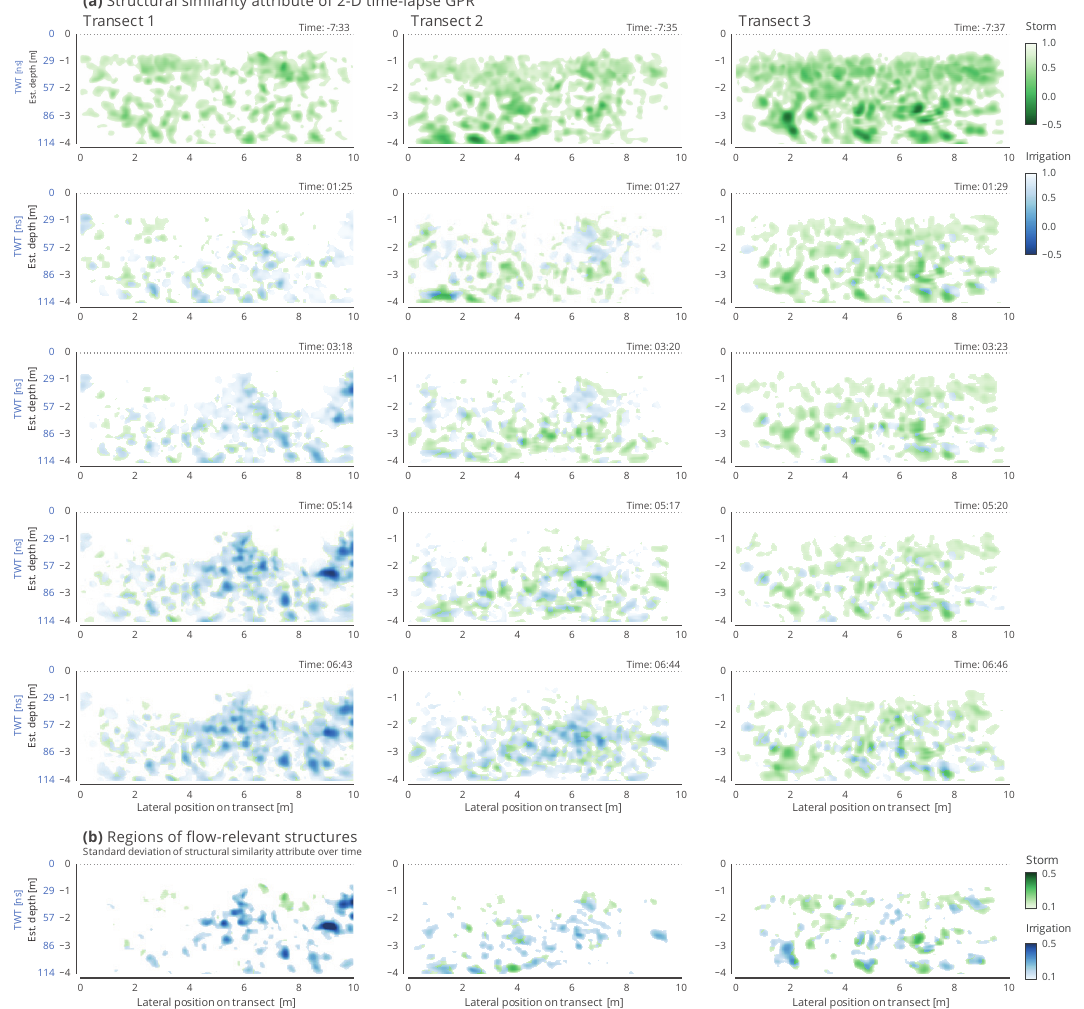
Figure 12. Structural similarity attribute in time-lapse 2-D GPR transects. Blue: irrigation event water; green: storm event water. Columns: time series in one transect; rows: different transects at the same time. (b) Identified regions of rapid subsurface flow based on the standard deviation of all structural similarity attributes at one transect over time. Note: the structural similarity attribute calculates similarity between the radargram at the respective time to the last record 23h past irrigation. A threshold of 0.15 is applied to identify significant changes. It is a qualitative measure based on the assumption that the last record is in steady state and that all differences are induced by soil water